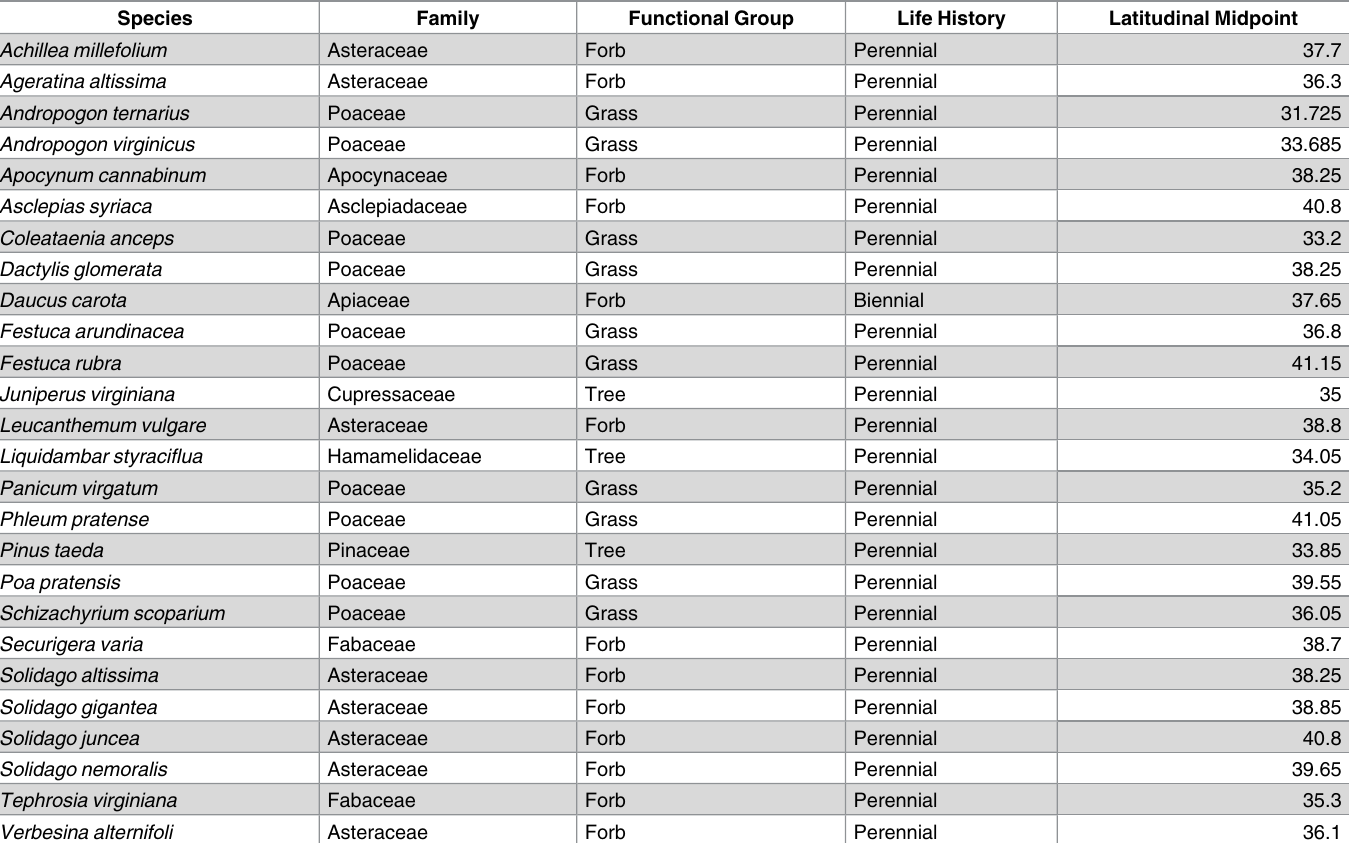
Table 1. Summaryof species included in this